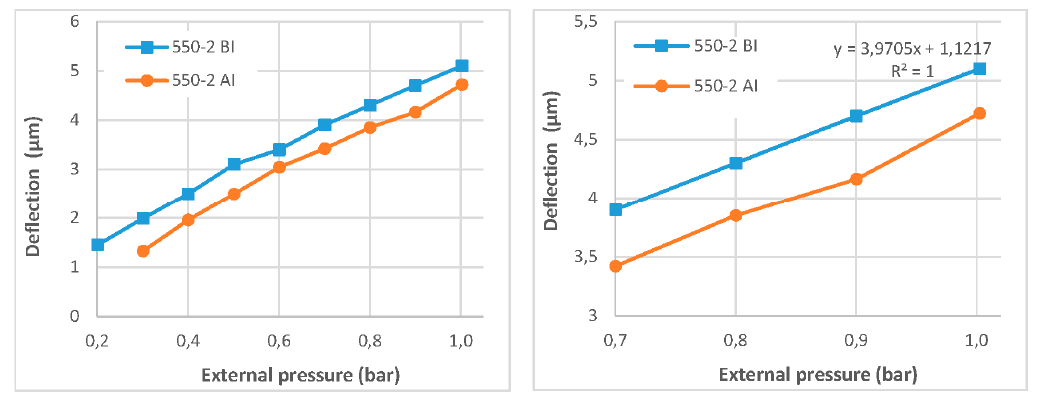
Figure 6. Membrane deflection versus external pressure applied on the top of the membrane (BI: Before Irradiation, AI: After